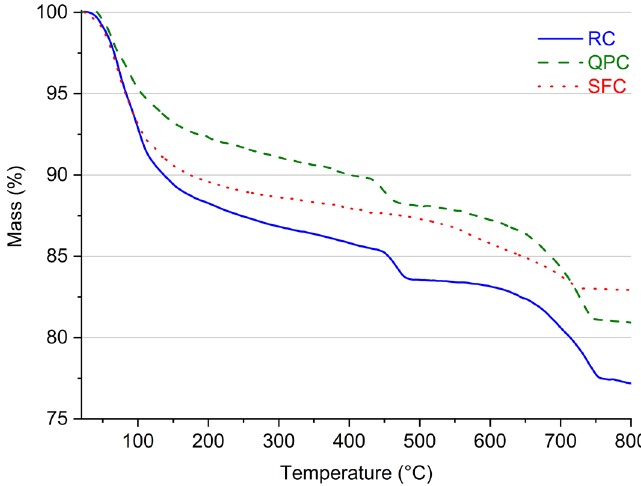
Figure 5. TGA curves of the RC, SFC and QPC.